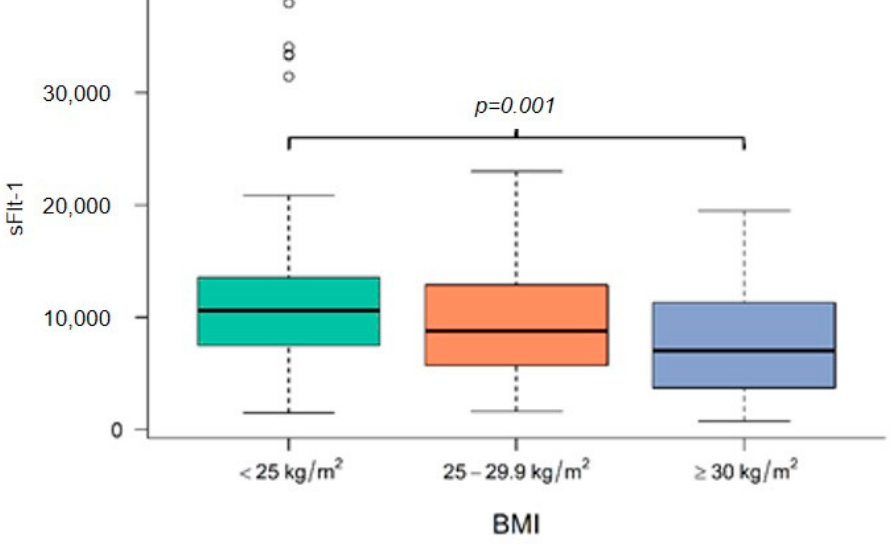
Figure 2. Level of sFlt-1 at diagnosis in normal-weight, overweight and obese women. BMI body mass index, sFlt-1 soluble fms-like tyrosine kinase-1.